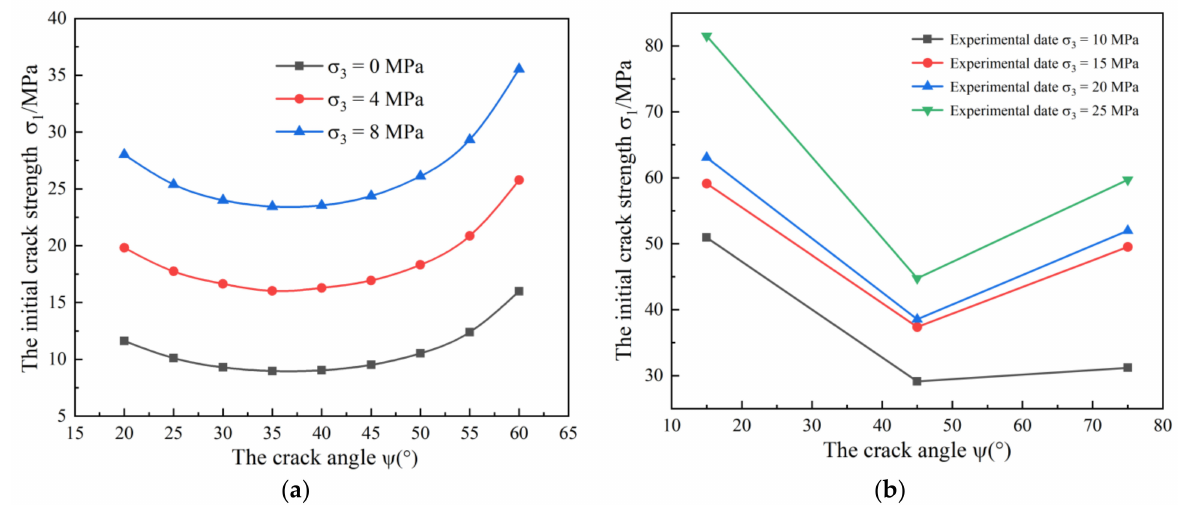
Figure 4. The crack initiation strength under different factors on confining pressure. ( a ) Theoretical data; ( b ) experimental data